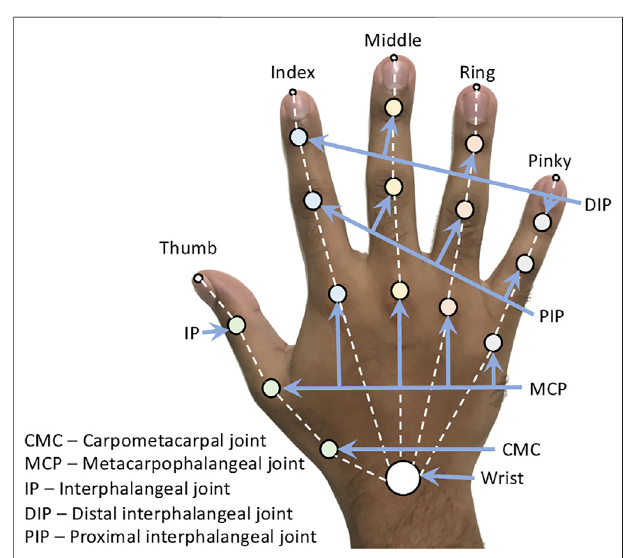
FIGURE 2 | Structure of the human